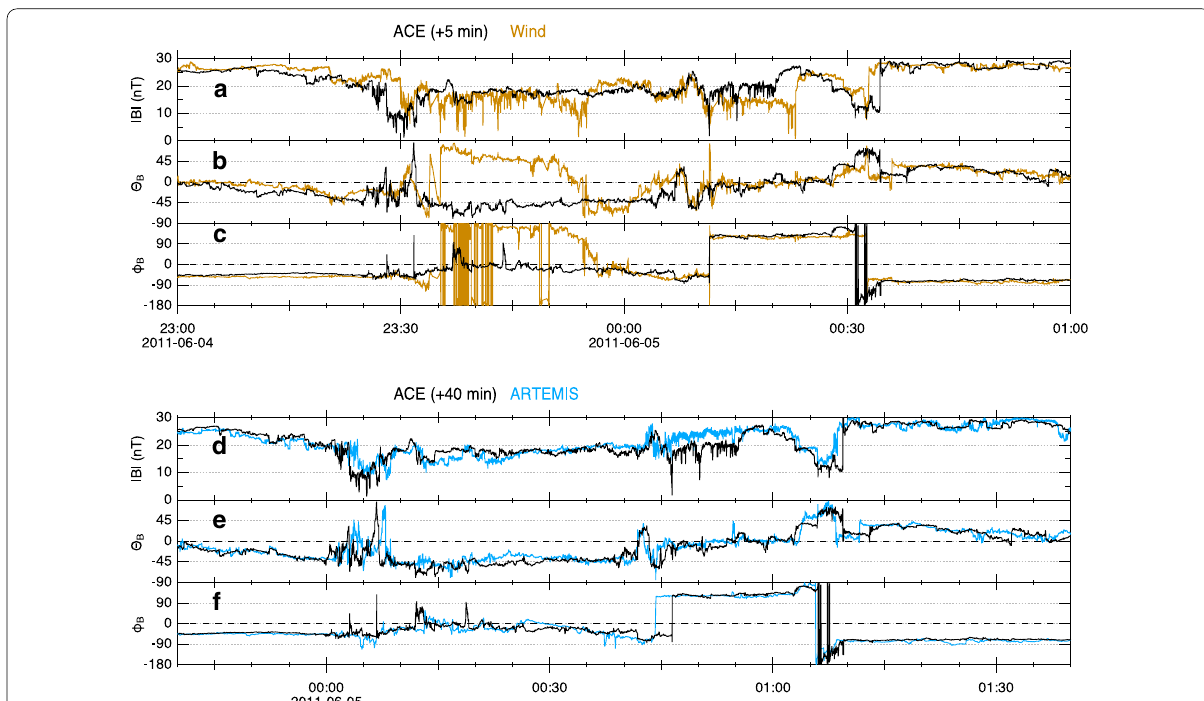
Fig. 4 Enlarged view of the magnetic cavity embedded in the ICME sheath. a – c Variation of the magnitude (| B |), latitudinal direction ( θ B ), and longitudinal direction ( φ B ) of the magnetic field vector measured by ACE (black) and Wind (brown). d – f Same as a – c but measured by ACE (black) and ARTEMIS (blue). To account for the solar wind propagation, the ACE data are shifted in time by 5 and 40 min for a – c and d – f , respectively. In d and e, data from P1 (THB) of the twin spacecraft mission ARTEMIS are shown with the time resolution of ~ 0.25 s. Due to artificial noise in the φ B component of this data product, data from P2 (THC) are used in f with the time resolution of ~ 3